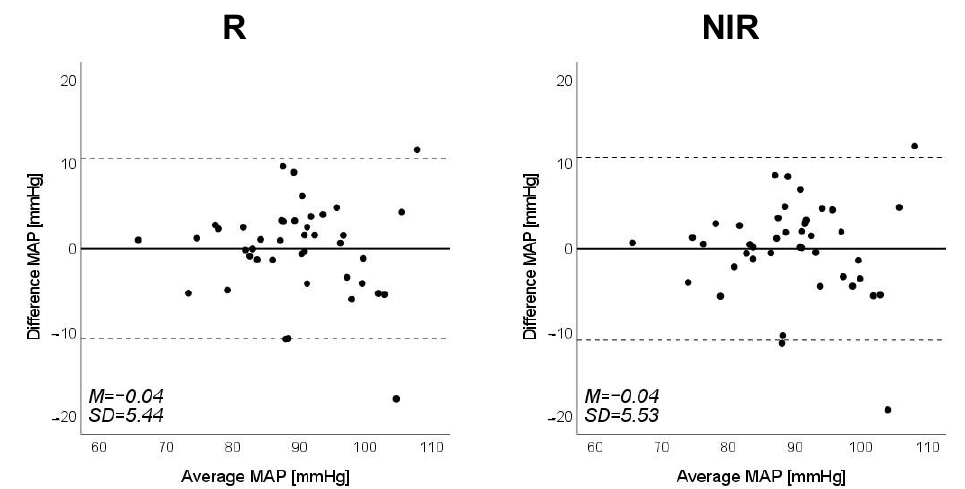
Figure 11. Bland–Altman plots of estimated mean arterial pressure (MAP) against those measured with a cuff sphygmomanometer ( N = 42). From left to right, the light source is blue (B), green (G), red (R), and near-infrared (NIR). The solid line and the dashed lines on each plot represent fixed bias (M) and M ± 1.96 standard deviation range, respectively. Table 4. Difference between estimated BP and measured BP with a cuff sphygmomanometer. SBP DBP MAP